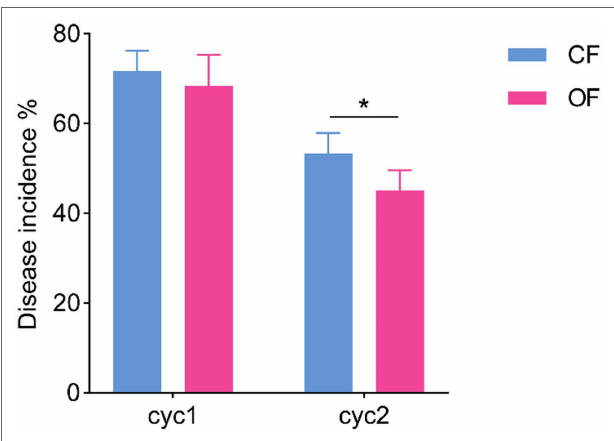
FIGURE 1 | Effects of different fertilization management practices on tomato disease. CF, chemical fertilizer; OF, organic fertilizer. * p < 0.05.